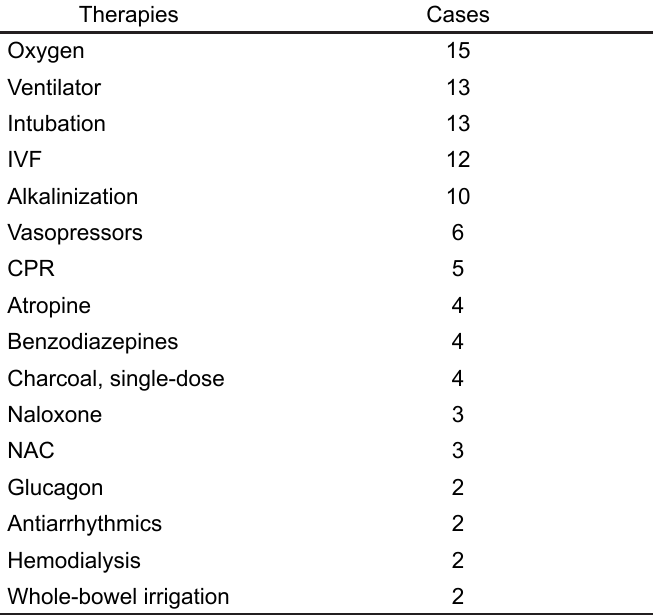
Table 3. Therapies used in death cases.